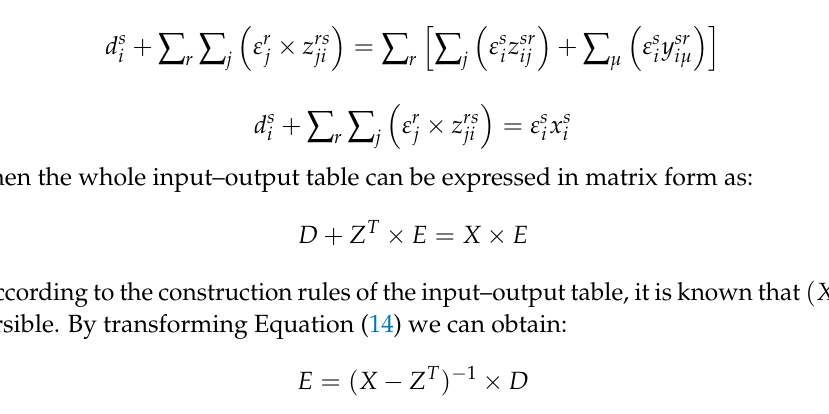
Figure 1. Schematic diagram of the embodied energy balance principle for sector i in province s